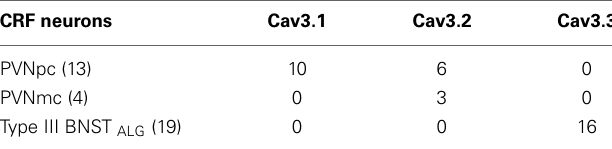
Table 3 | Comparison of mRNA transcript expression of I T current channel subunits in PVN and BNST ALG CRF